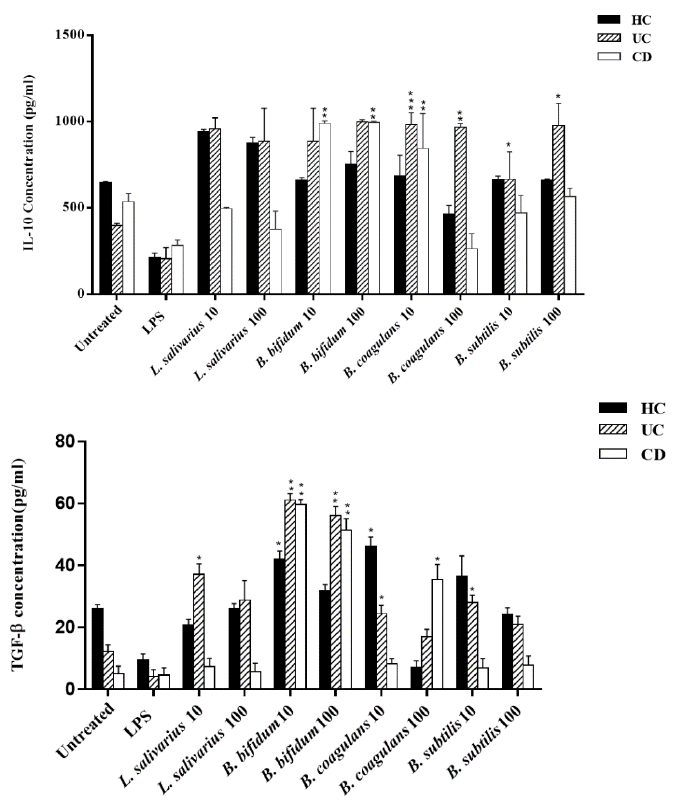
Figure 4. Effects of probiotics on anti-inflammatory cytokine production by DCs. HC: healthy controls, UC: ulcerative colitis, CD: Crohn’s disease. * p < 0.05, ** p < 0.01, and *** p < 0.001.